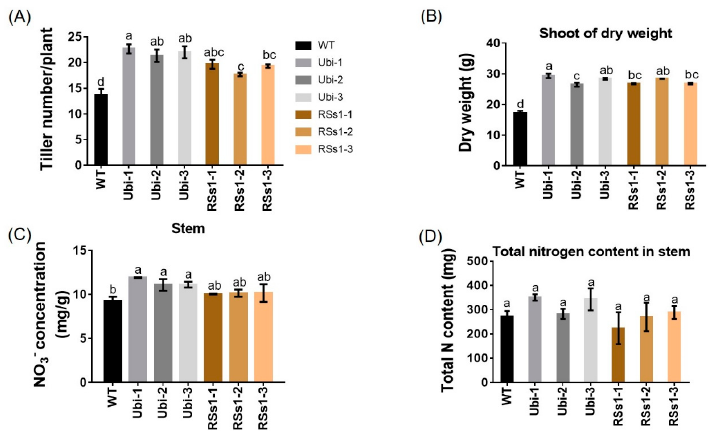
Figure 5. Physiological indexes of shoots. ( A ) Tiller number, ( B ) dry weight, ( C ) nitrate concentration, and ( D ) total N content in shoots at maturity in pot experiments. Different letters indicate a significant di ff erence between transgenic lines and WT ( p < 0.05, one-way ANOVA). Error bars: standard error ( n = 4